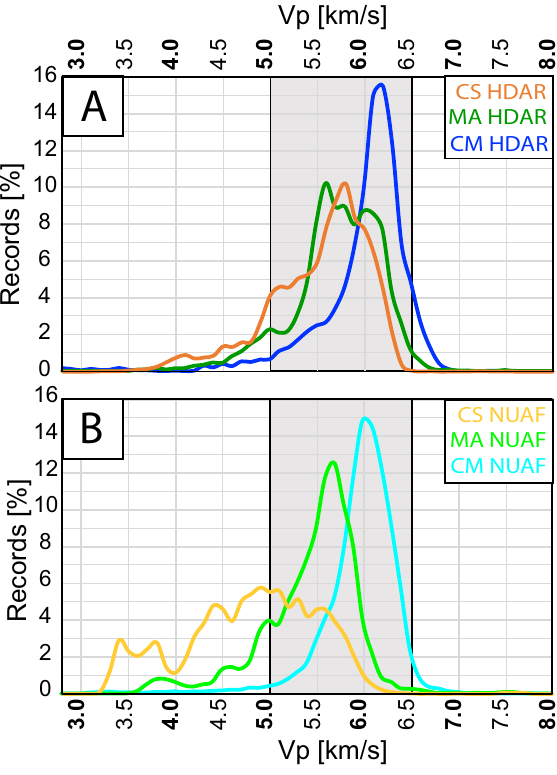
Figure 8. Comparison of frequency histograms normalized respect to the total number of measurements (see text for a detailed explanations) for the three carbonates litho-stratigraphic units. ( A ) Normalized frequency histograms of Calcare Massiccio (Blue), Maiolica (Green) and Calcareous Scaglia (Orange) measured in the Highly-Deformed Apennine Ridge (HDAR). ( B ) Normalized frequency histograms of Calcare Massiccio (Cyan), Maiolica (light Green) and Calcareous Scaglia (Yellow) measured in the nearly-Undeformed Adriatic Foreland (NUAF). For clarity, we normalized the frequency values so that the sum of the reported frequencies for each lithostratigraphic unit pertaining to each of the structural domain, is equal to 100. In other words, we plot the data so that a value of 10 in the y axis and 6.0 km/s in the x axis in the curves in Fig. 8 means that the 10% of the measurements recorded 6.0